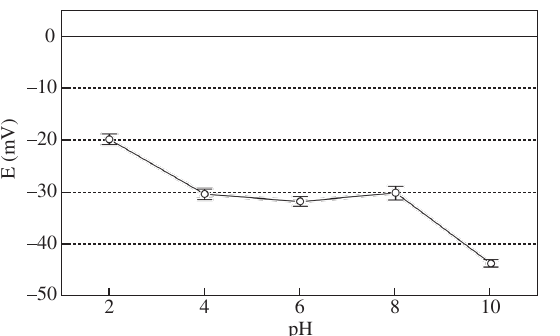
Figure 9. Equilibrium data (isotherm) of sulphate ions uptake, from aque- ous solutions, by powdered modified zeolites. Contact time: 2 hours, Ba-Z: 10 g.L –1 , temperature: 25 °C, pH 6.0.